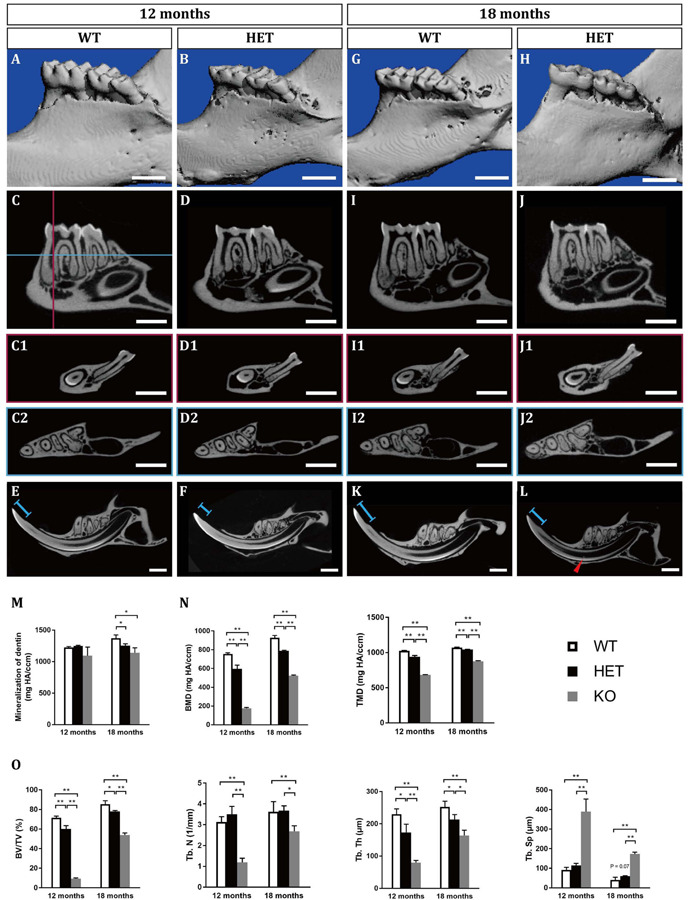
Tooth phenotypes in Dspp heterozygous mice at the ages of 12 months (A–F) and 18 months (G–L), resembling dentin dysplasia type II (DD-II). (A,B,G,H) Reconstruction images of the micro-CT scanning in wild type (WT, Dspp+/+) and Dspp heterozygous (HET, Dspp+/–) mice. (C,D,I,J) Sagittal sections of the mandibles in WT and HET mice, showing the largest sections of the mandibular first molars and the mandibular second molars. (C1,D1,I1,J1) represented the coronal sections of the largest sections of the mesial roots of the mandibular first molars, as illustrated in (C) the vertical red line. (C2,D2,I2,J2) represented the horizontal sections of the mandibles, as illustrated in (C) the horizontal blue line which was approximately 0.3 mm below the alveolar ridge at the furcation of the mandibular first molars. (E,F,K,L) Sagittal sections of the mandibular incisors. Red arrowheads pointed to the pulpal stones in the mandibular incisors. Blue lines indicated the lengths between the incisures on the lingual sides of the mandibular incisors and the cusps. (M) The mineralization of dentin of the mandibular first molars. (N,O) Parameters related with interradicular septum between the two roots of the mandibular first molars. BMD, bone mineral density; TMD, tissue mineral density; BV/TV, bone volume fraction; Tb. N, trabecular number; Tb. Th, trabecular thickness; Tb. Sp, trabecular separation. For each group, n = 5. *P < 0.05; **P < 0.01. Scale bars = 1 mm.